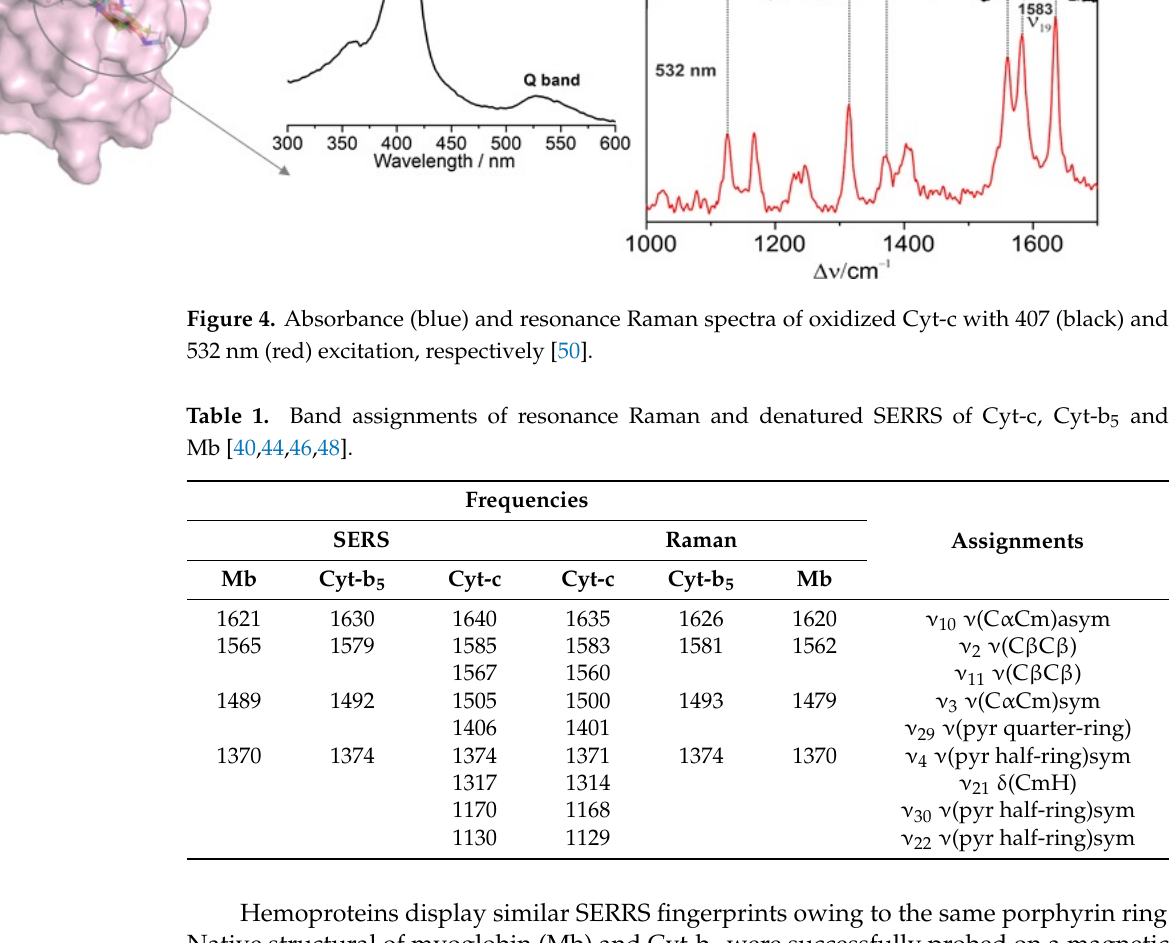
Figure 5. SERRS of hemoproteins including Cyt-c, Mb, and Cyt-b 5 . ( A ) SERRS of different oxidation, spin, and coordination states of Cyt-c immobilized on a CO 2 -SAM Ag electrode measured with 413 nm excitation. Reprinted with permission from [49]. Copyright [2004] American Chemical Society. ( B ) (Black) SERRS of deoxyMb (red) and Mb (ox) on a magnetic-Ag hybrid material (adapted with per- mission from [40]. Copyright [2013] American Chemical Society), and (purple) two redox states of Cyt-b 5 on a TiO 2 electrode (adapted with permission from [33]. Copyright [2013] John Wiley and Sons).